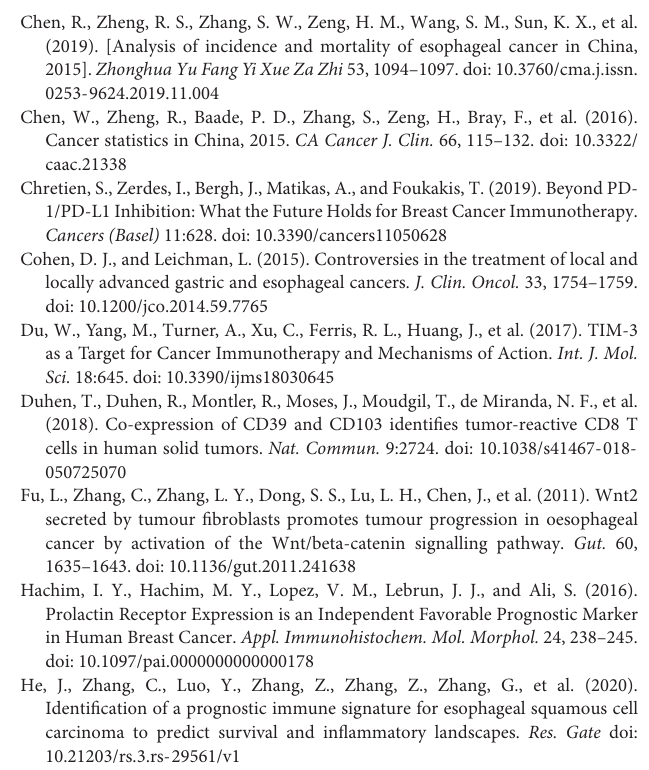
Supplementary Figure 1 | The six-immune-related gene signature generation pipeline. Supplementary Figure 2 | Survival analysis of all ESCC patients in the training cohort stratified by lymphatic metastasis and stage. (A,B) Kaplan-Meier curves of OS in LN+ and LN − patients of the training cohort. (C,D) Kaplan-Meier curves of OS in early and advanced stages. Supplementary Figure 3 | Survival analysis of all ESCC patients in the training cohort stratified by age and gender. (A,B) Kaplan-Meier curves of OS in older and younger patients of the training cohort. (C,D) Kaplan-Meier curves of OS in male and female patients of the training cohort. Supplementary Figure 4 | Survival analysis of all ESCC patients in the training cohort stratified by tobacco and alcohol history. (A,B) Kaplan-Meier curves of OS in smoker and non-smoker patients of the training cohort. (C,D) Kaplan-Meier curves of OS in drinker and non-drinker patients of the training